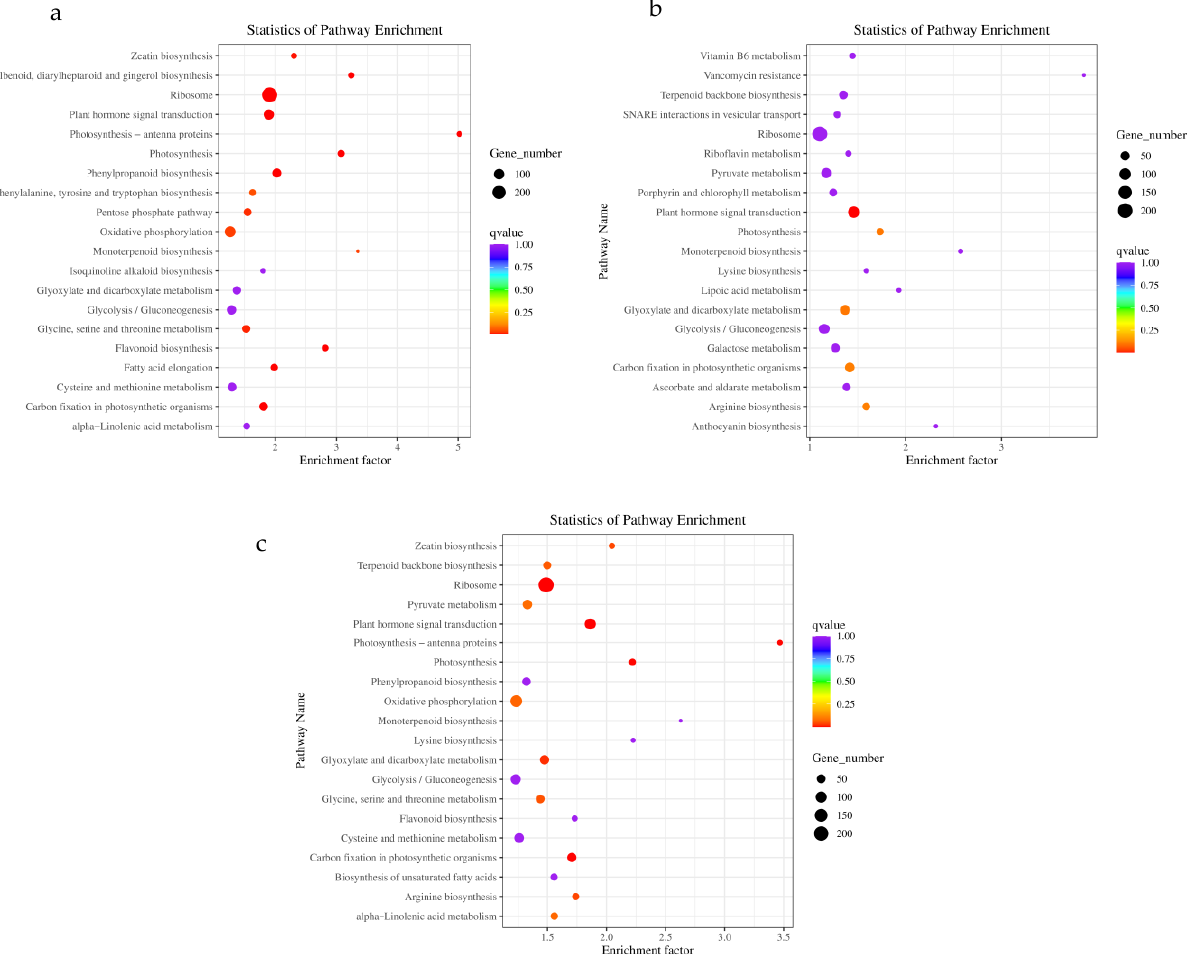
Figure 4. KEGG enrichment analysis of differential genes. ( a ) CK VS MJ50; ( b ) CK VS MJ100; ( c ) CK VS MJ250.